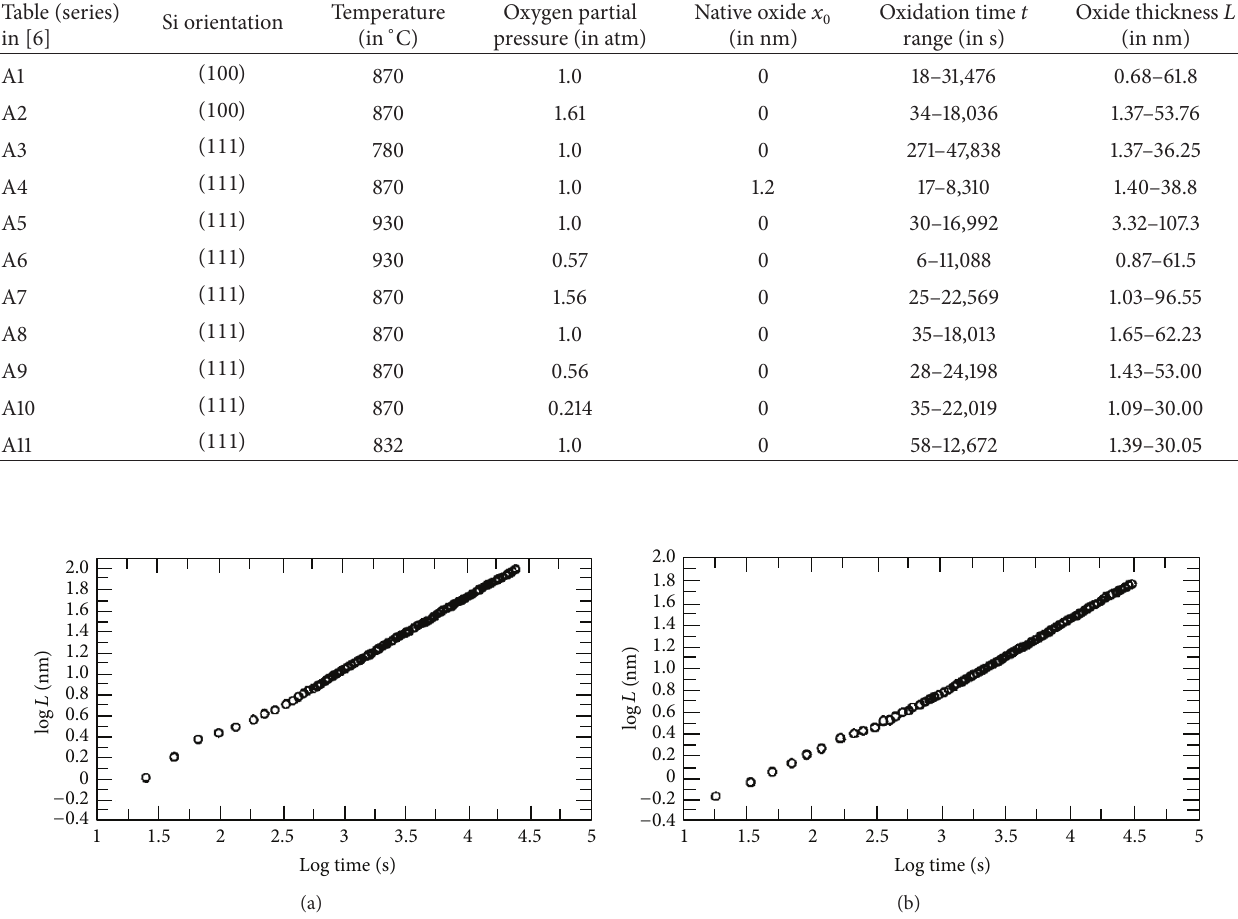
Figure 2: Oxide thickness 𝐿 versus oxidation time 𝑡 for (a) Si (111) at 870 ∘ C and 1.56 atm and (b) Si (100) at 870 ∘ C at 1atm (from